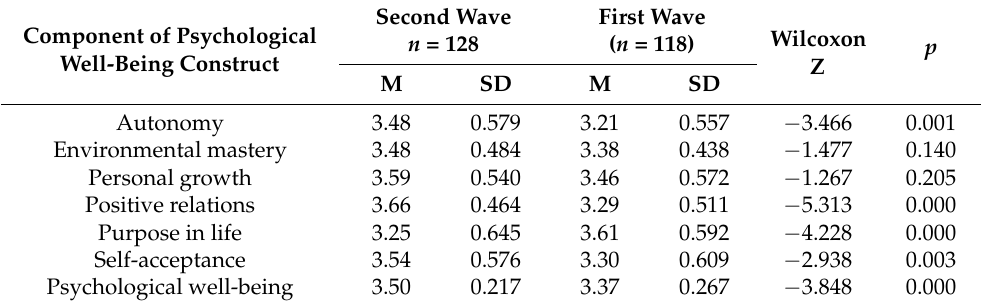
Table 4. Estimations of components of psychological well-being after the first and second wave. Component of Psychological